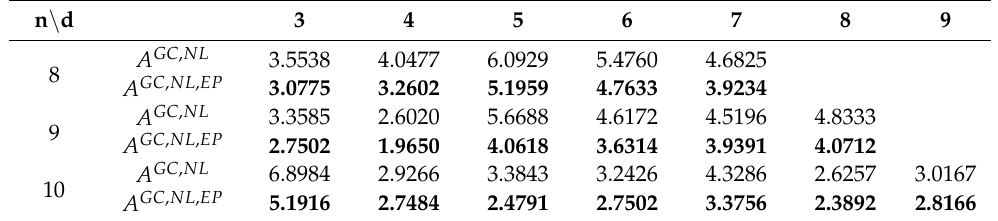
Table 9. Comparison results of the melting temperature variance, where the best results are bolded to indicate.